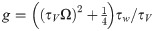
The type of w-current depends on the values of the intrinsic parameters.(a) Intrinsic parameter phase diagram in (τw/τV, g). w can be depolarizing (g < 0) or hyperpolarizing (g > 0). w contributes an intrinsic frequency to the model in the colored region. The dynamics are unstable if g < −1. Iso-Ω lines are shown in white (g=((τVΩ)2+14)τw/τV for large τw and g=12(τV2τw-1) for small τw). (b) When λ±∈C, the phase diagram can be cast in (τw/τV, Ωτ
V)-space. Iso-g lines are shown in white. (See [29] for a similar plot).